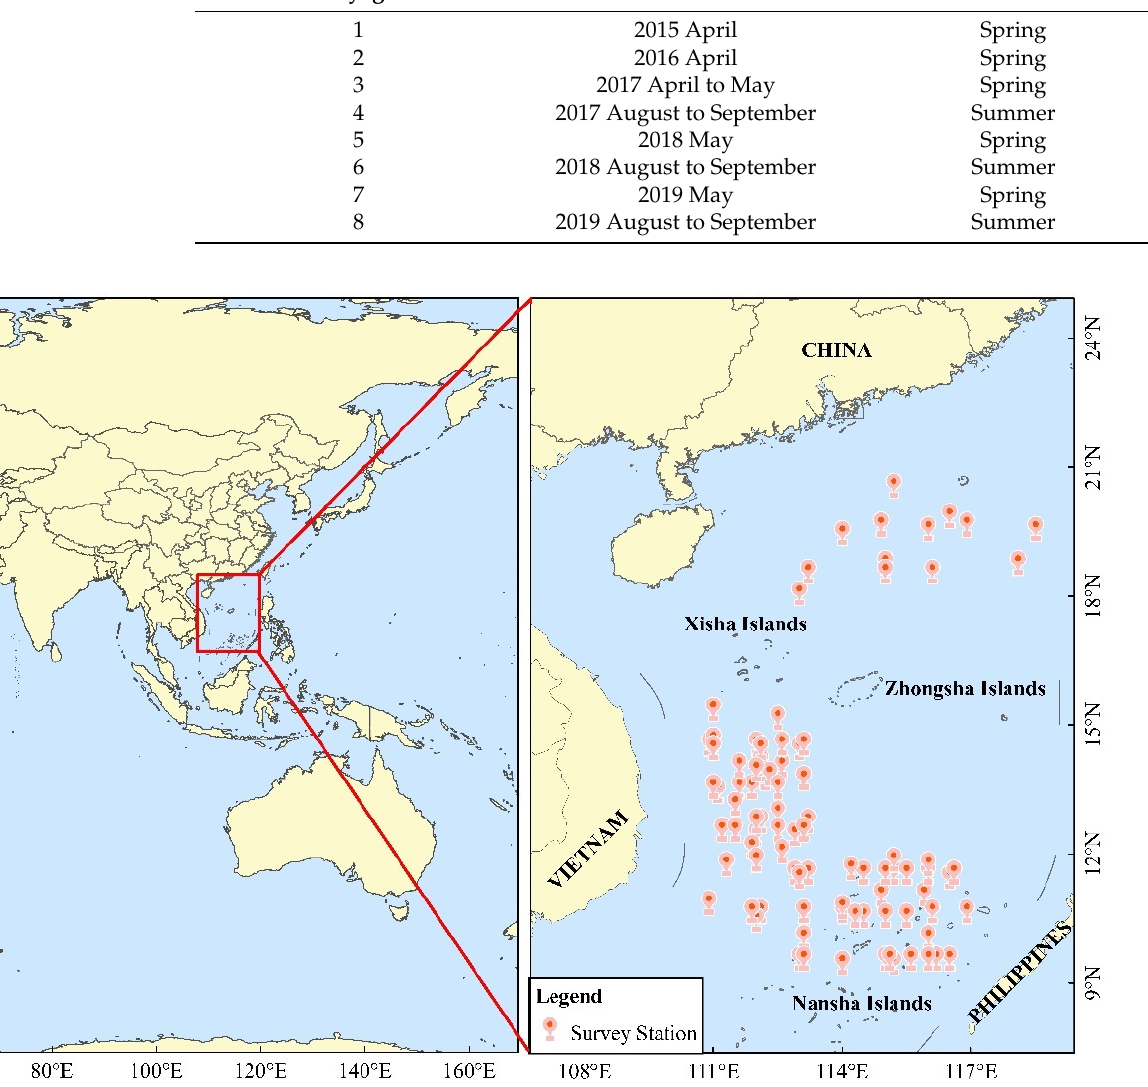
Table 1. Survey sampling times.